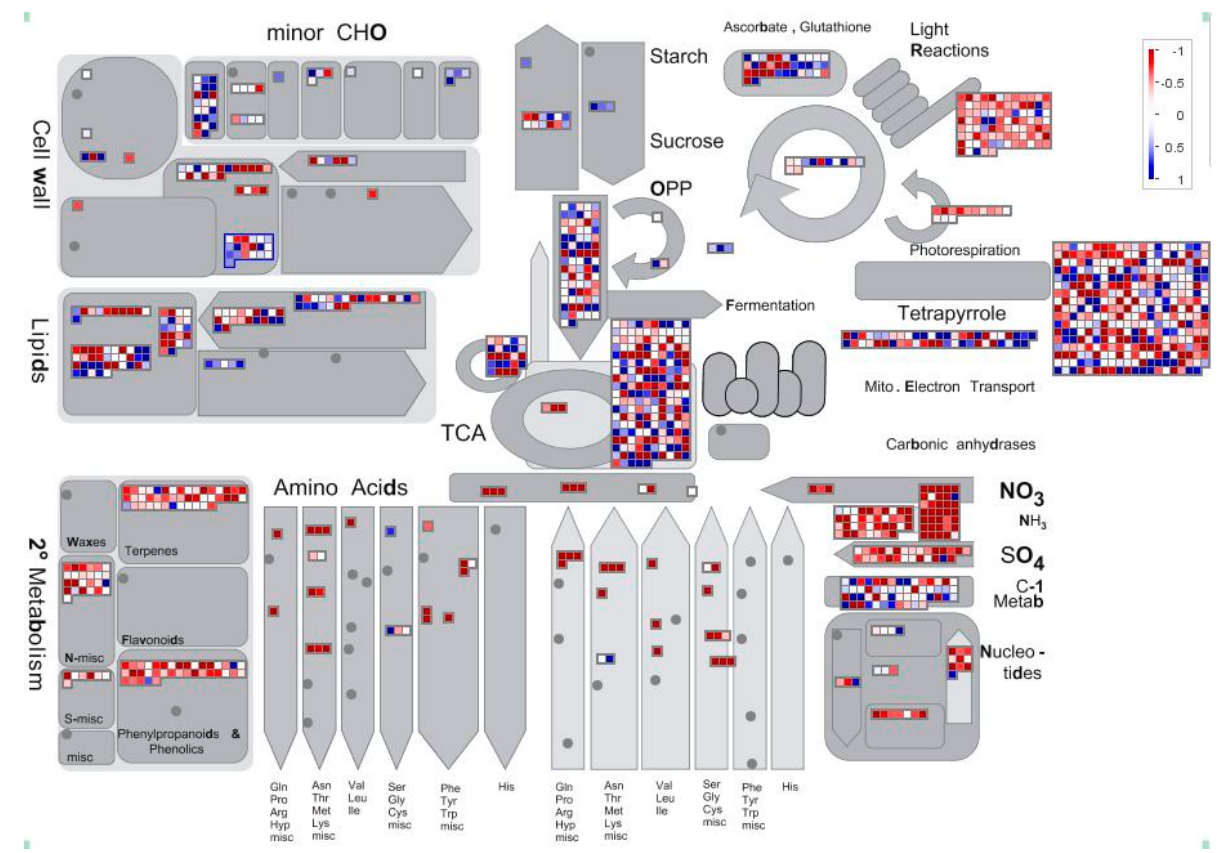
Figure 6. Metabolism overview produced by MapMan software. Each color block represents a separate gene; red indicates upregulated expression, and the darker the color, the higher the expression. Blue indicates the down-regulation of expression, and the darker the color, the lower the expression.